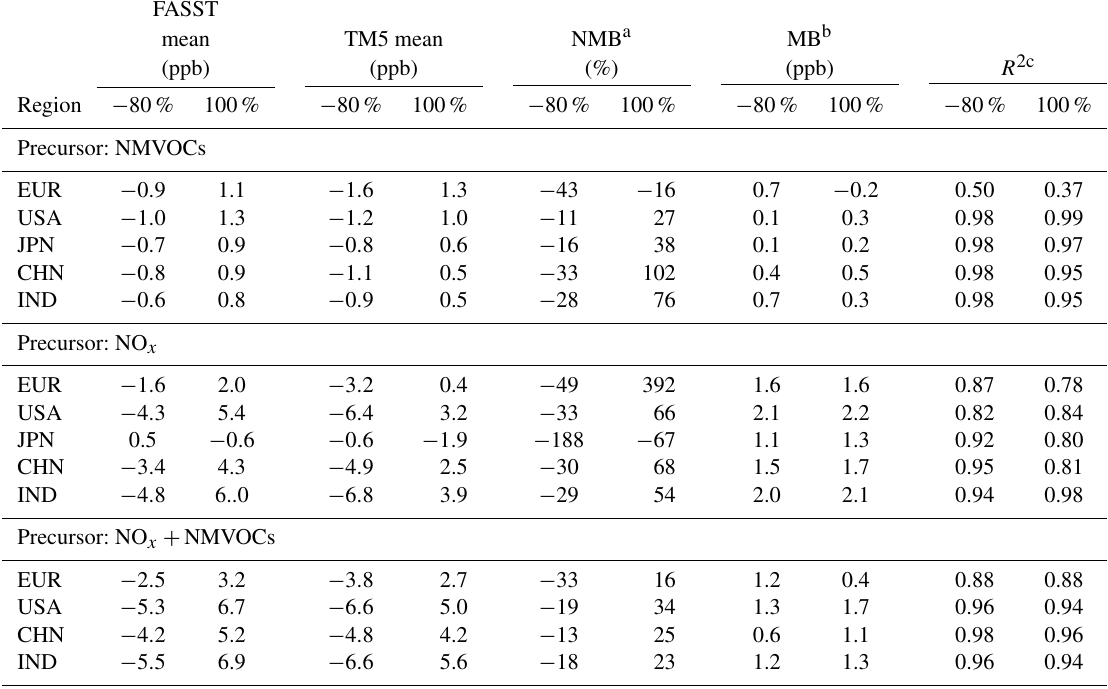
Table 7. Statistical metrics describing the correspondence between the linearized FASST- and TM5-computed change in O 3 crop exposure metric M12 upon − 80% and 100% emission perturbation in its precursors (NMVOCs, NO x , and combined NO x + NMVOCs), relative to the RCP2000 base scenario. Statistics are calculated over all 1 ◦ × 1 ◦ grid cells in each region.